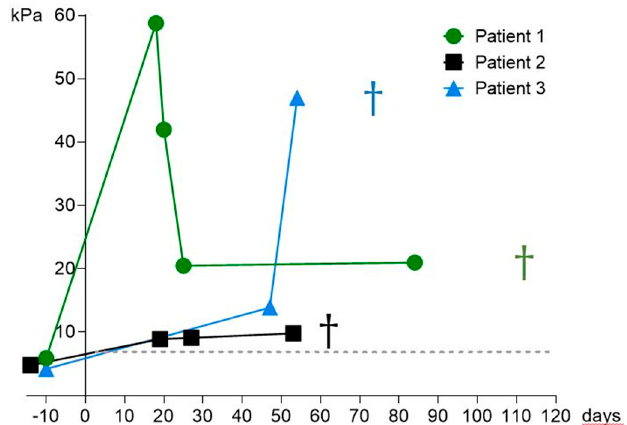
Figure 2. Courses of SWE values (kPa) of the three SOS/VOD patients. Day 0 is the day of HSCT, Patient 1 died on day +110, Patient 2 died on day +63, and Patient 3 on day